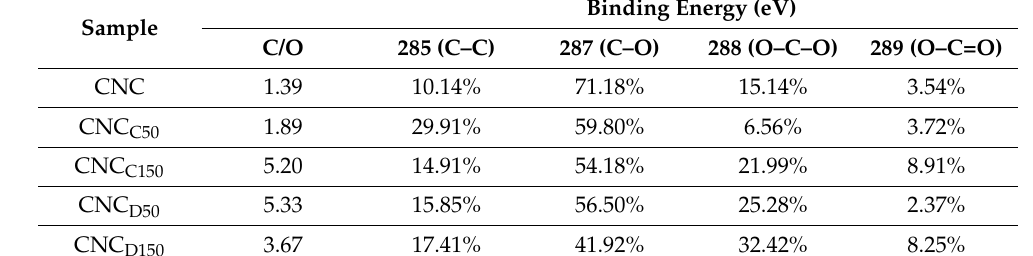
Table 4. Surface composition of pristine and modified CNCs calculated by XPS and the C 1s high- resolution data.